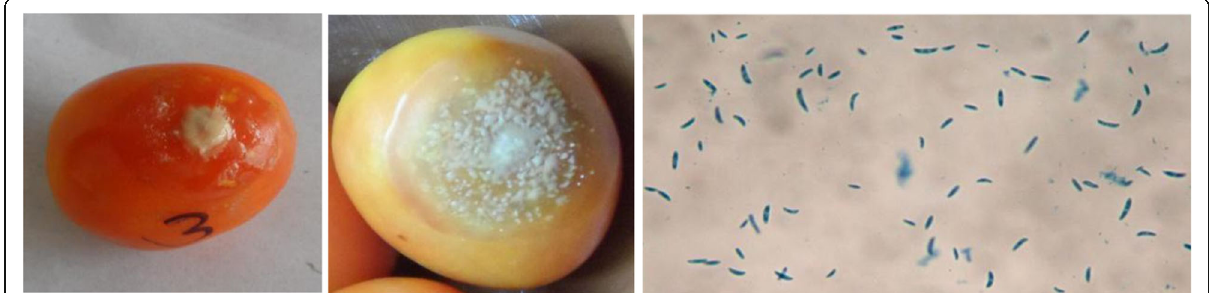
Fig. 4 Photographs showing disease ( a ) symptom of Fusarium rot and ( b ) micro conidia of Fusarium